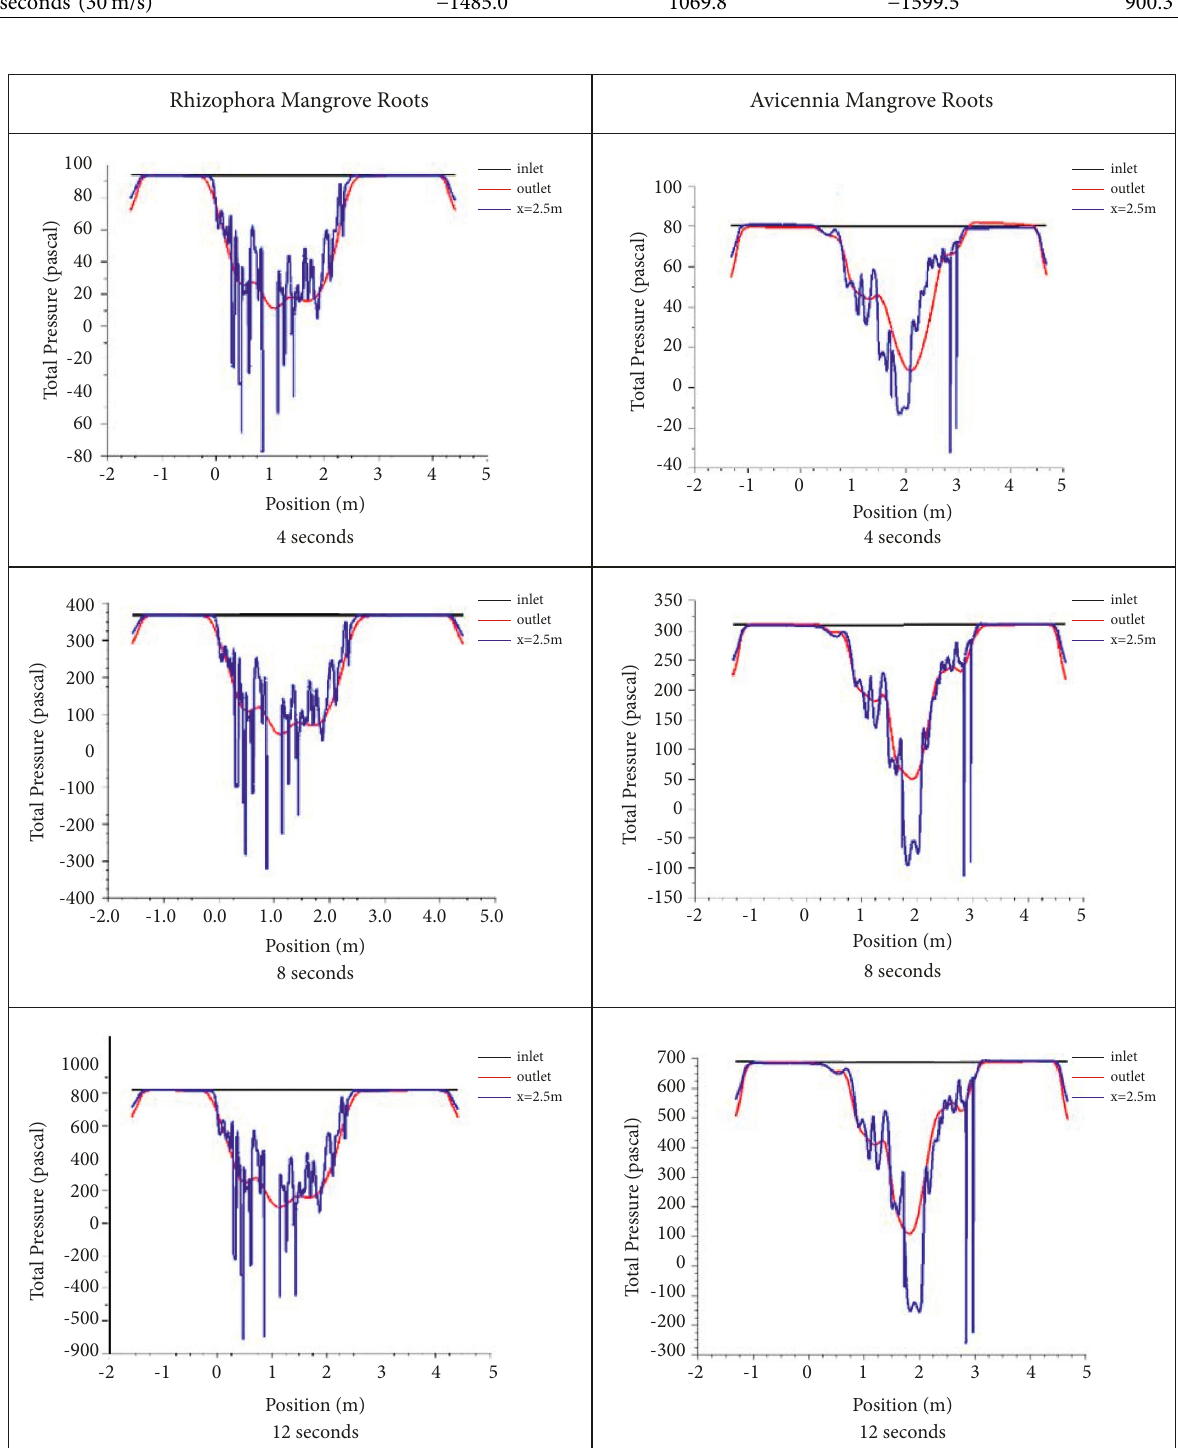
Figure 9: Pressure changes of unsteady air flow by Rhizophora and Avicennia mangrove roots at inlet, outlet, and x �